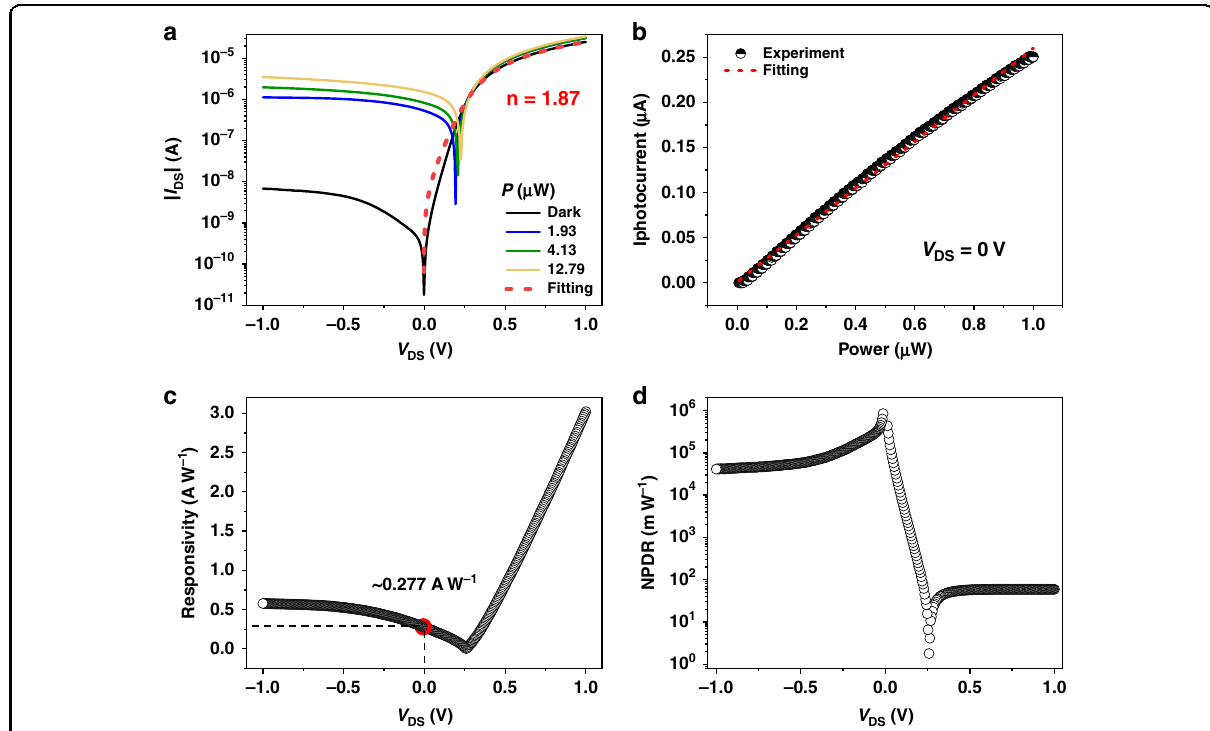
Fig. 2 Electrical characteristics and photoresponses (with the coupling light at 1503nm) of the waveguide-integrated BP/MoTe 2 heterojunction photodetector. a Measured current – voltage characteristics of the photodetector without (black line) and with optical illuminations at different BP absorption powers. b Measured zero-bias photocurrents versus the absorbed optical powers. c Intrinsic responsivity as a function of the bias voltage. d Normalized photocurrent – dark-current ratio (NPDR) as a function of the bias